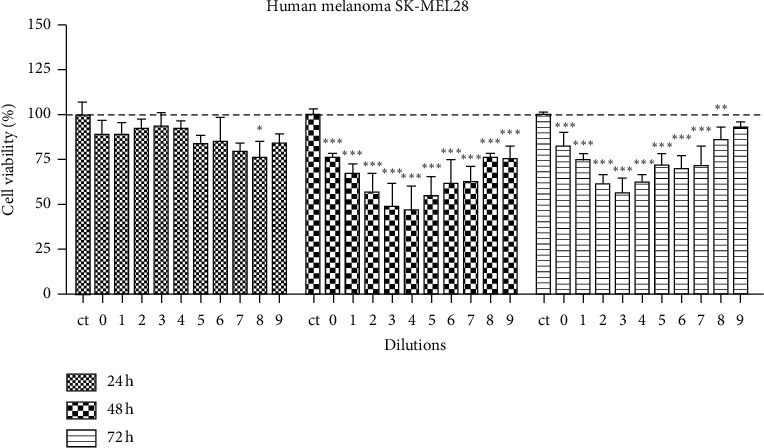
SK-MEL 28 human melanoma cell viability after treatment with different dilutions of E. tirucalli latex. The dilutions were numbered as follows: 0 (E. tirucalli latex standard solution–1 mg/mL), 1(1/2), 2(1/4), 3(1/8), 4(1/16), 5(1/32), 6(1/64), 7(1/128), 8(1/256), and 9(1/512). The control group (ct) received 50 μl/well of saline solution. ∗p < 0.05,∗∗p < 0.01,∗∗∗p < 0.001.